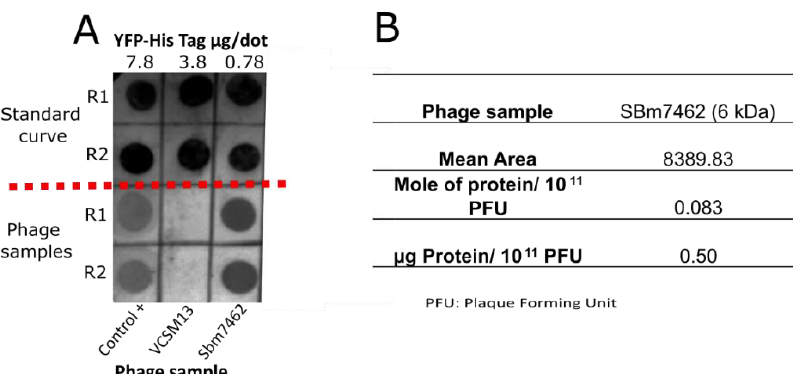
Figure 3. Determination of antigen expression on the surface of recombinant phages. ( A ) Curve of mean area vs mole of recombinant yellow fluorescent protein (YFP) that contains a His-tag was used to determine by densitometry analysis the mole of antigen expressed per PFU unit. Different quan- tities of YFP were applied in duplicate. Different concentrations of yellow fluorescent protein were used to construct a standard curve for densitometry analysis. For phage samples, 1 × 10 11 PFU per dot were applied. ( B ) Determination of mole and µg of protein (Sbm7462 antigen) per phage unit (PFU). R, replicate. Control +, phage expressing a tetanus toxin Fab, VCSM13, negative control